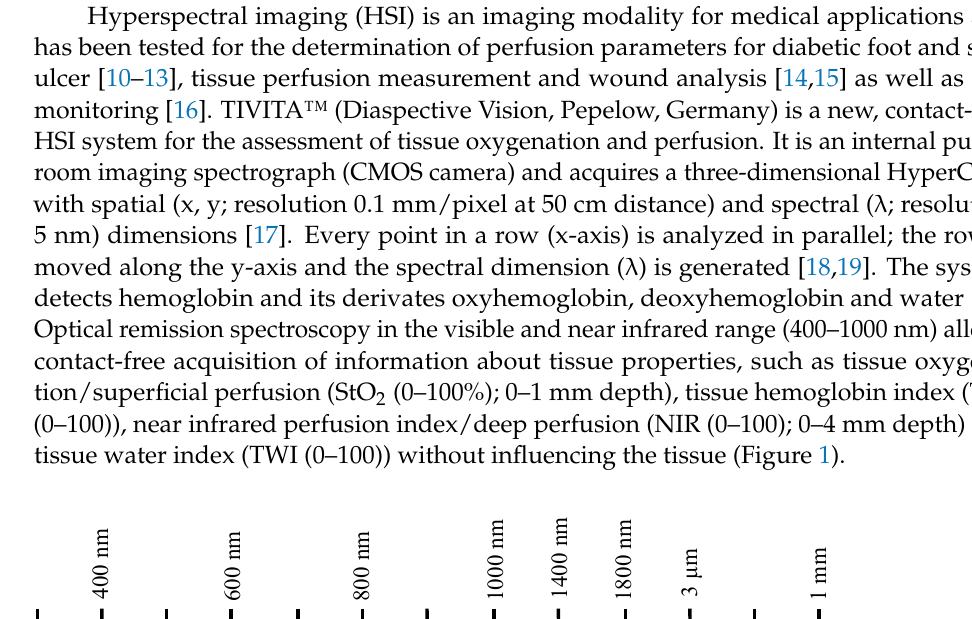
describes the existing hemoglobin distribution in the superficial microcirculatory